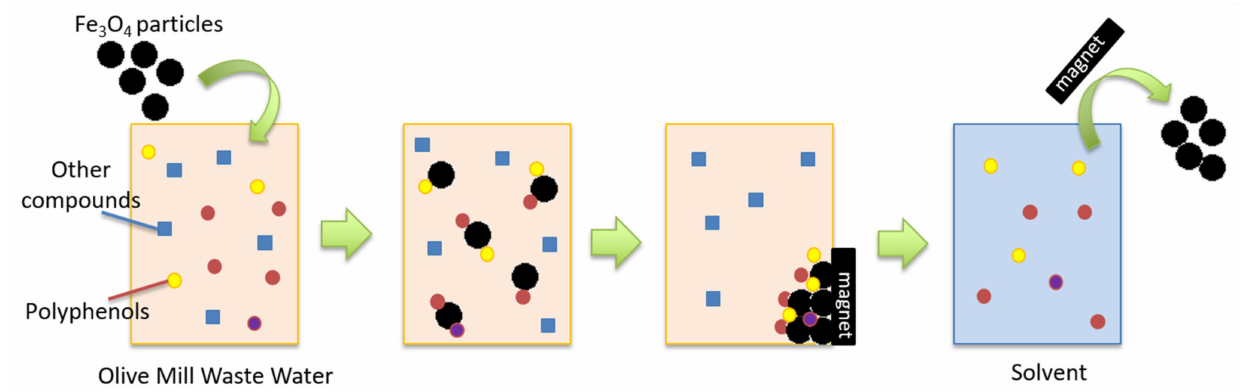
Figure 2. Scheme depicting the removal of polyphenols by the use of Fe 3 O 4